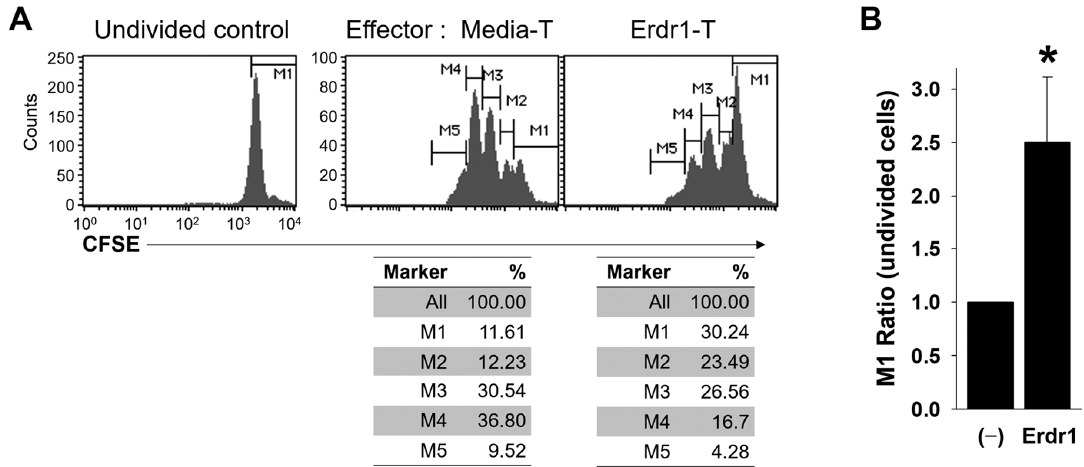
Figure 4. Erdr1-activated Treg cells are functionally suppressive. CD4 T cells from lymph nodes of DBA1 were cultured with media alone (Media-T) or Erdr1 (1 µg/mL, Erdr1-Treg) in the presence of TCR stimuli and used as effector cells. CFSE-labeled (2 mM) responder CD4 T cells were co-cultivated with the effector cells (1:1 ratio) in the presence of anti-CD3 ε antibody (0.5 µg/mL) for 3 days. ( A ) Proliferation of responder cells (gated on CFSE + cells) were determined by flow cytometry. ( B ) Ratios of the undivided cells (M1) were compared and presented as mean ± SD from three independent experiments in duplicate ( n = 3). * p < 0.05 (vs. Media-T control).